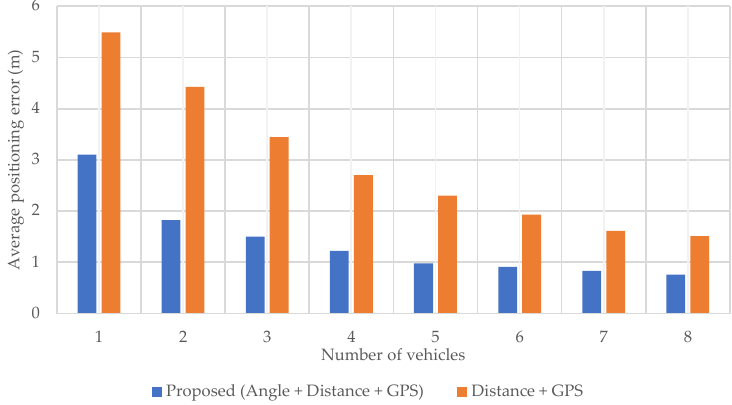
Figure 15. Average horizontal positioning error for each number of vehicles.